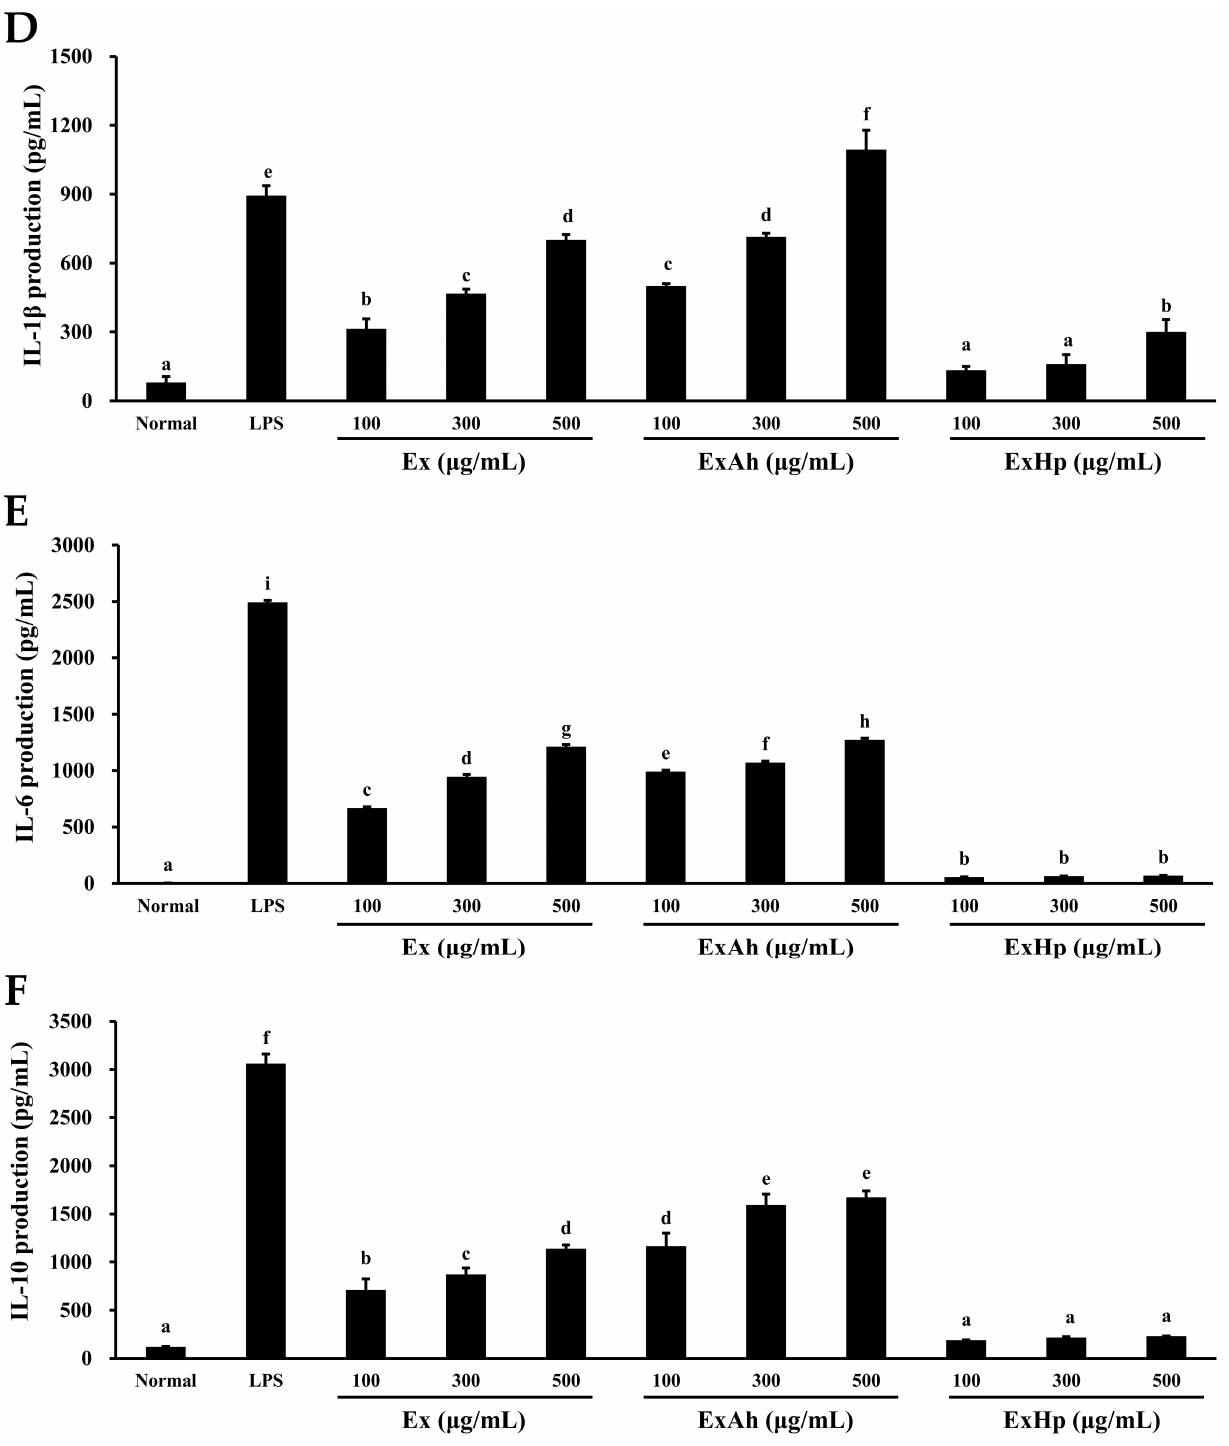
Figure 3. Effects of various concentrations of Ex, ExAh, and ExHp on cell viability, NO produc- tion, TNF- α production, IL-1 β production, IL-6 production, and IL-10 production in RAW 264.7 macrophages. ( A ) cell viability, ( B ) NO production, ( C ) TNF- α production, ( D ) IL-1 β production, ( E ) IL-6 production, and ( F ) IL-10 production. Values are mean ± SD (n = 3); values in the same graph with different letters (in a, b, c, d, e, f, g, h, and i) are significantly different ( p <